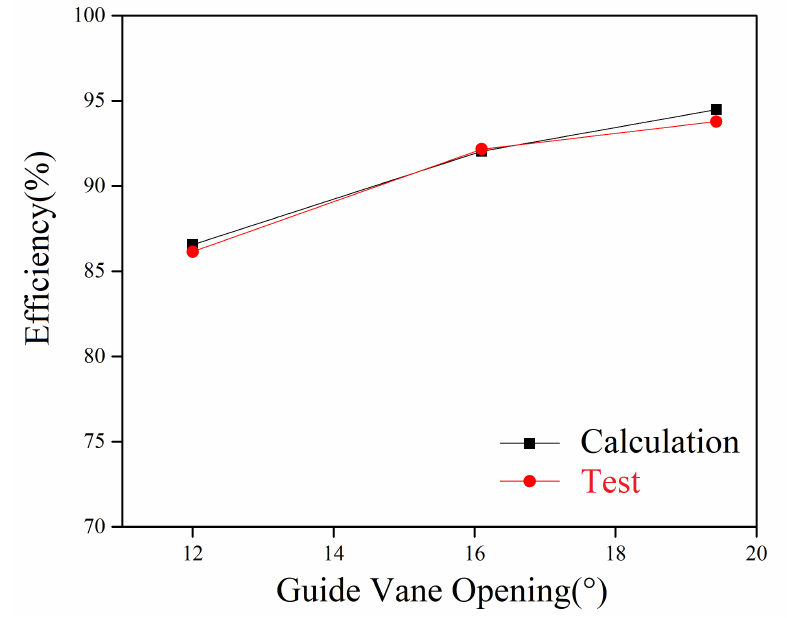
Figure 9. Efficiency comparison between calculation and